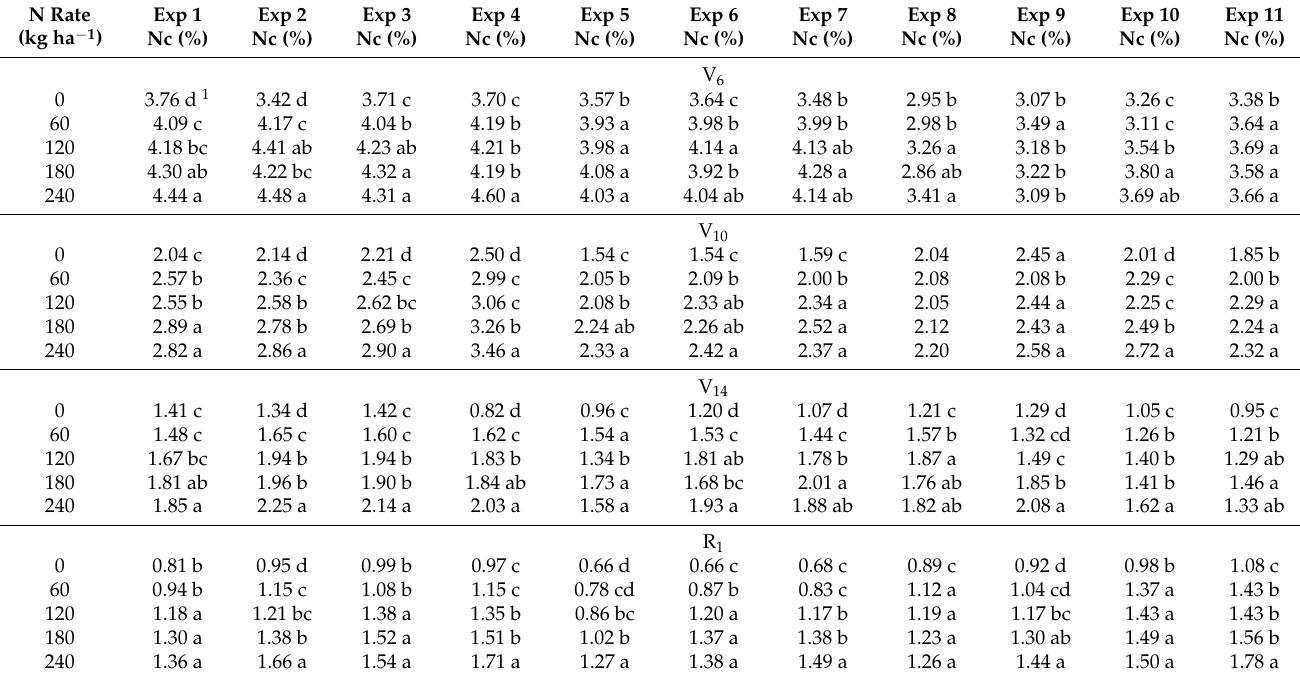
Table 4. Plant nitrogen concentration (Nc) for each nitrogen (N) rate, crop growth stage, and experiment (Exp). Each value represents the average of 3 replicates.